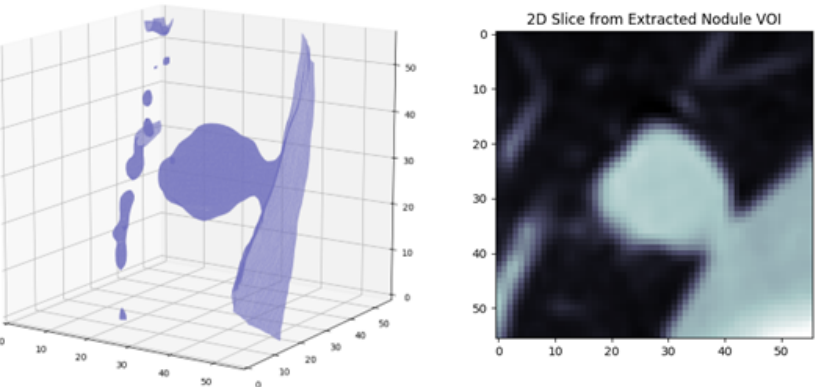
Figure 10. 3D extracted volume of interest is given on the left and 2D transverse seen of the slice is given on the right.